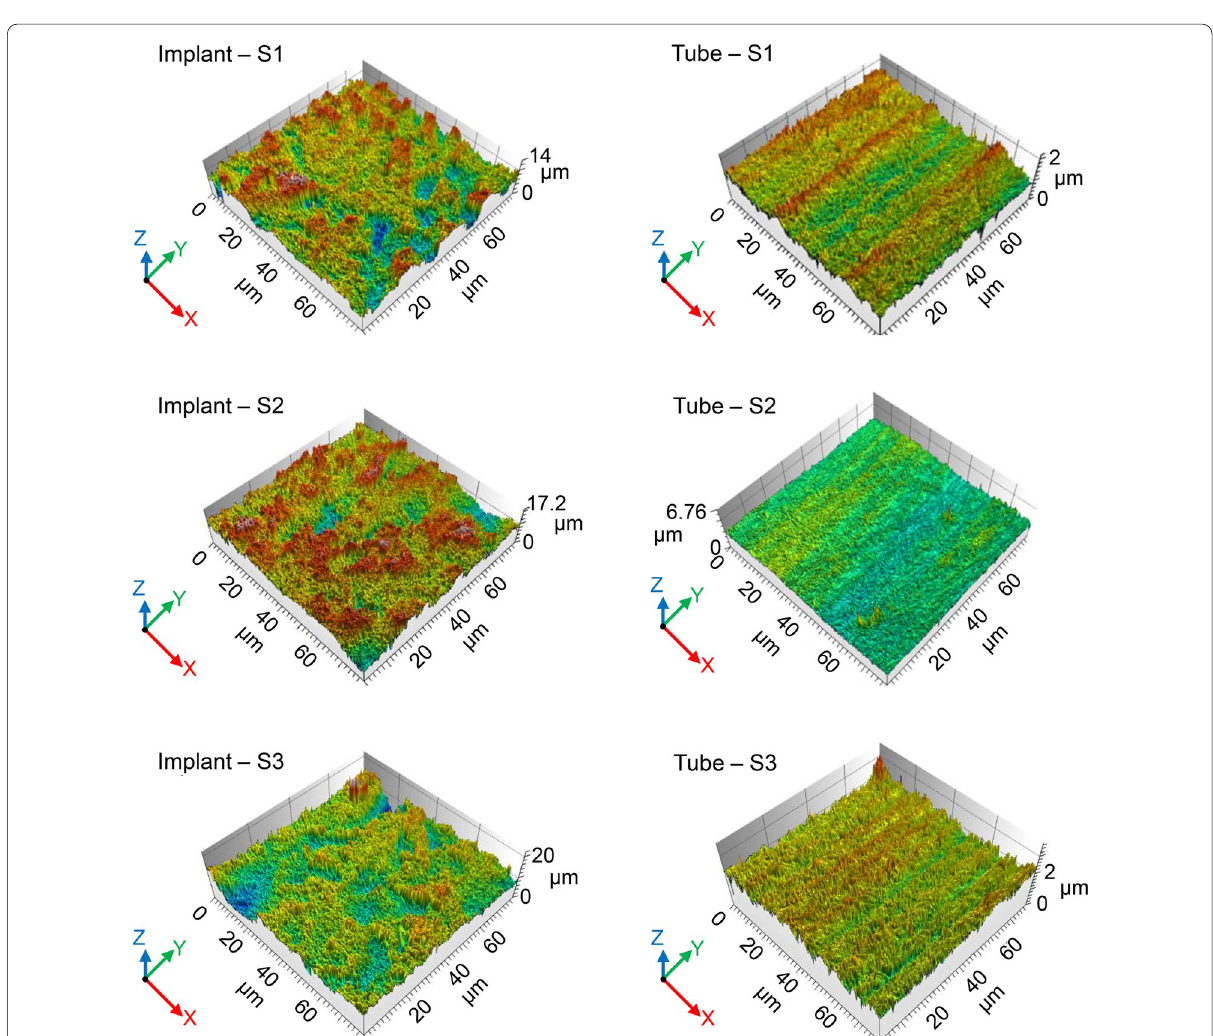
Fig. 3 Confocal laser scanning microscopy of the surface of implant and tube specimens. Notice that the SLA implant specimens (left) have rougher surfaces than the turned or unmodified tube specimens (right), particularly in the Z‑axis. S